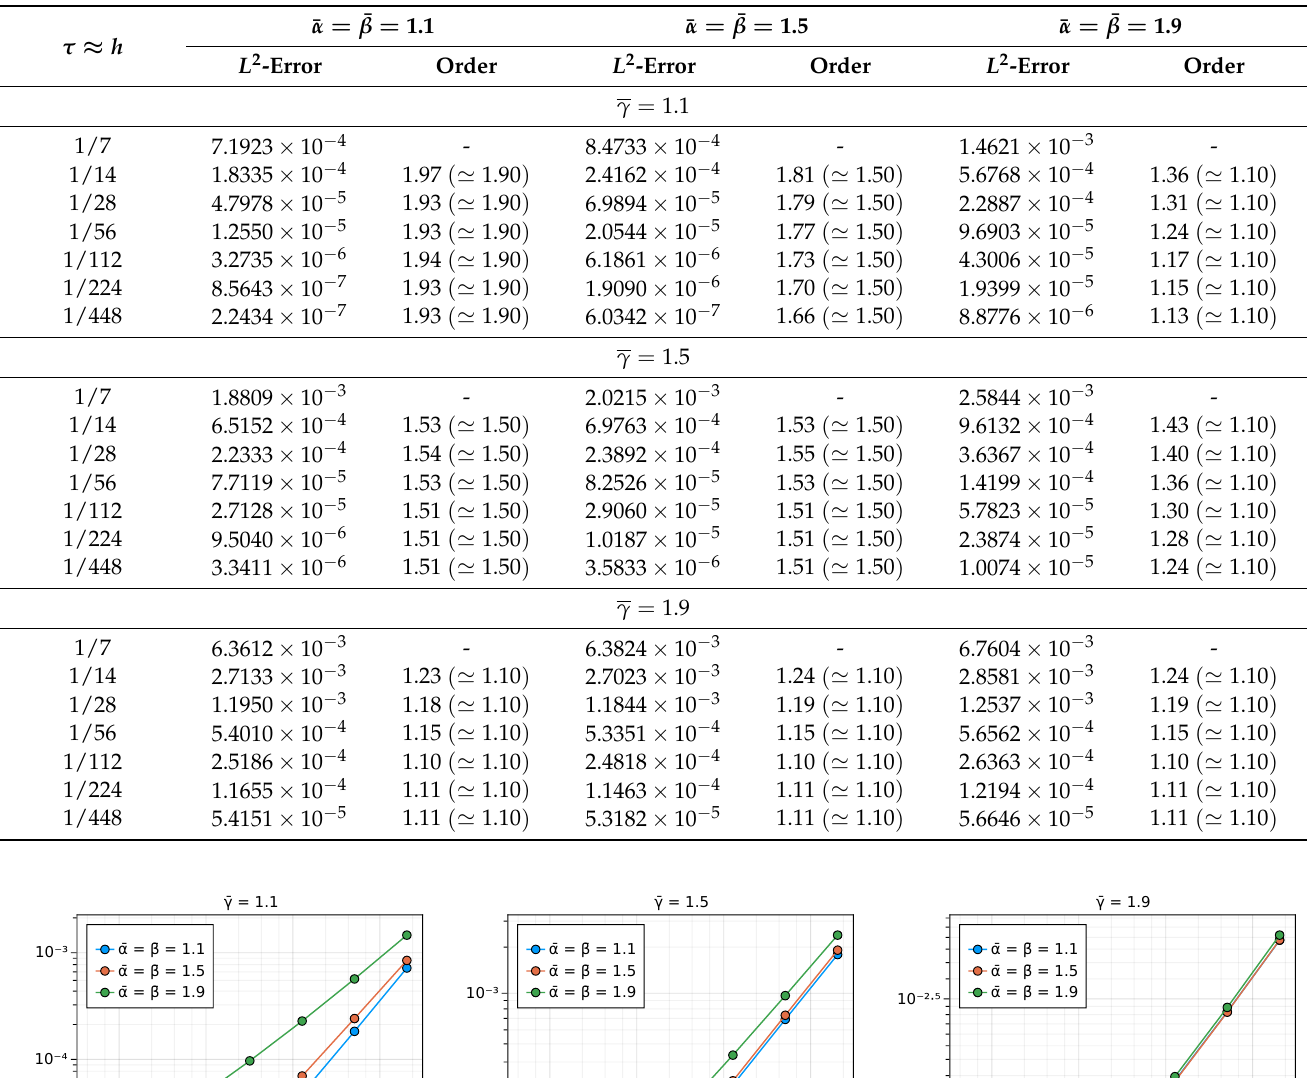
, i ≥ 2, calculated by i